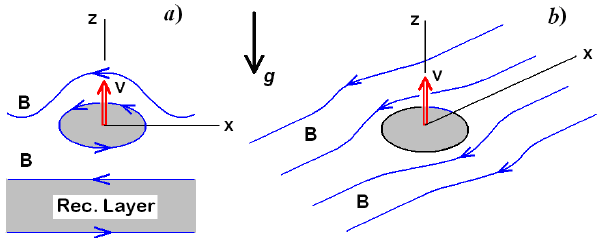
Figure 8 . A schematic showing a detached quasi-spherical bubble, filled in with hot plasma and surrounded by closed magnetic field lines (shown by blue lines) as a result of magnetic reconnection; the closed magnetic field supports the bubble in equilibrium. B is the magnetic field, g is the quasi-gravitational acceleration directed parallel to the z-axis normally to the reconnection layer. The ambient magnetic field is assumed to decrease along the z-axis. The hot plasma bubble is expelled toward the weaker magnetic field (along the z-axis) due to the effective buoyancy force and moves upward at the velocity V . The left panel shows the motion of the bubble in the x-z plane. The right panel shows motion of the bubble in 3-D space; the bubble moves upward in-between the ambient magnetic field lines. In a pseudo-gravitational field, associated with a force normal to the interface between two magnetic fields, the isolated plasma islands can move upward or downward dependently on the direction of the acting force. Since the plasma temperature within plasma bubbles is usually larger than that in surrounding plasma, they move against the gravitational or pseudo- gravitational force as shown in Figure 8. Assuming that the bubbles, detached from the reconnection layer, contain heated plasma and a reduced magnetic field, the plasma pressure in the bubble p 1 should be much higher than that in the ambient plasma, i.e., p 1 >> p 2 , while the magnetic pressure in the bubble B 12 /8 << B 22 /8 where index 2 is related to the region outside the bubble. Then in a quasi-stationary case from the balance of total (plasma plus magnetic field) pressures, we have p 1 B 22 /8 . For simplicity, we neglected here the magnetic tension force.